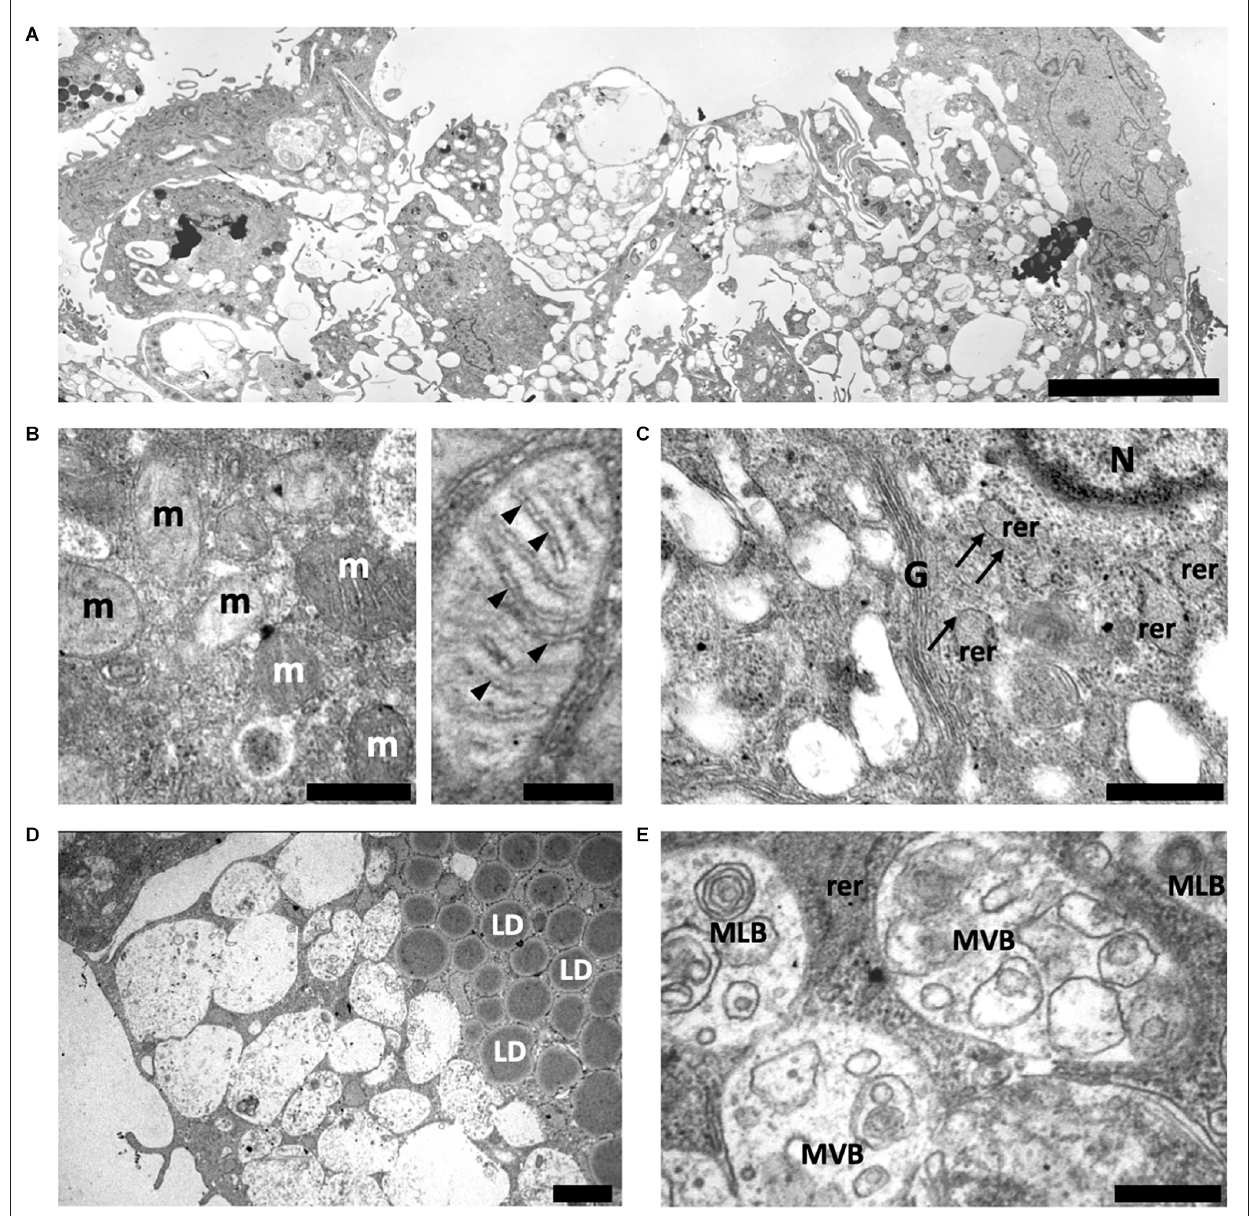
FIGURE4 Structure of spheroids of the adipose-derived multipotent mesenchymal stromal cells from old control CBA/Ca mice. (A) An overview of representative ADSCs spheroid after 14 days of culture. ADSCs are not tightly packed in spheroid and had a wide intercellular space. (B) Left electronogram—The mitochondrial population is heterogeneous and is represented by mitochondria with both electron-dense condensed and enlightened matrix. Right electronogram—A detailed view of round mitochondrion with enlightened matrix and cristae (arrowheads) arranged perpendicular to the mitochondrial tubular axis. (C) The ADSCs cytoplasm contains rough endoplasmic reticulum (rer) and well-developed Golgi apparatus (G). Areas of rough endoplasmic reticulum that do not contain ribosomes are marked with arrows. N—nuclei. (D) A large number of lipid droplets (LD) is observed in the ADSCs cytoplasm. (E) Typical multivesicular (MVB) and multilamellar bodies (MLB) are observed in the ADSCs cytoplasm. Scale bars: (A) —15 µ m, (B) left—0.5 µ m, right—0.2 µ m, (C,D) —1 µ m, (E) —0.5 µ m.